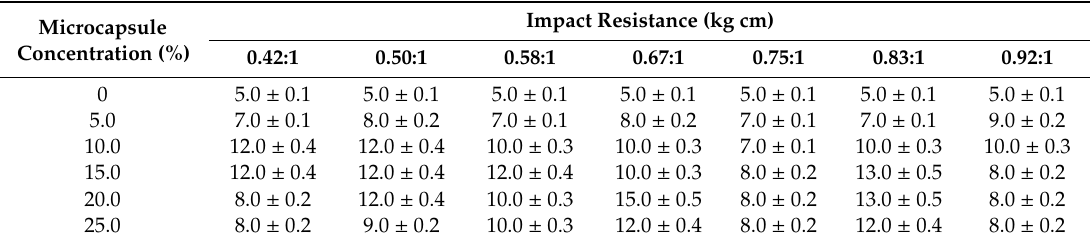
Table 7. E ff ect of the Concentration of Microcapsules with Di ff erent Core–Wall Ratios on the Impact Resistance of Waterborne Primer Coating.